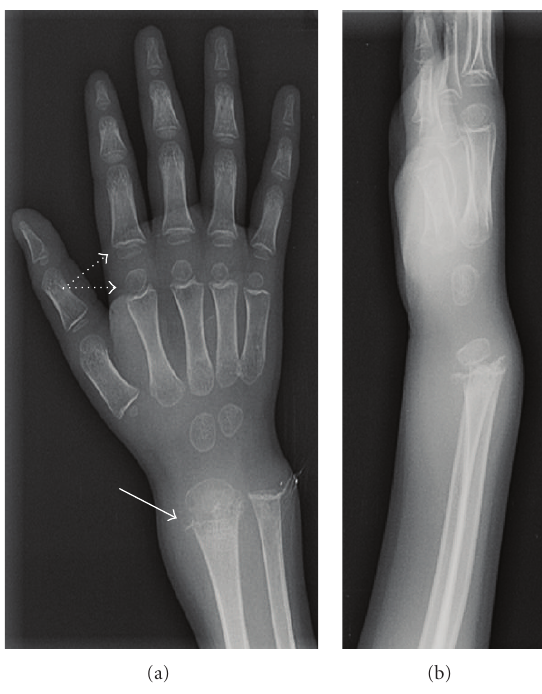
Figure 3: Anteroposterior (a) and lateral (b) X-rays of the hands and wrists showing severe osteopenia of the epiphyses of the phalanges (dotted arrow), metacarpals and the carpal bones, epiphyseal separation of the distal radius and ring sign